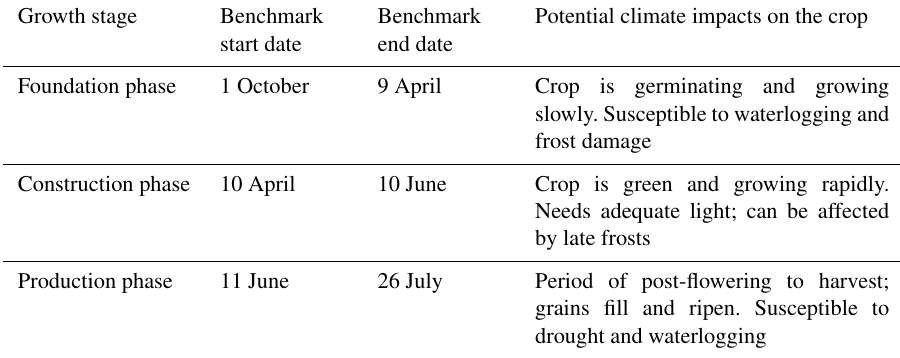
Table 1. Three standardized wheat growth stages, modified by 1d to avoid overlap across stages (AHDB,